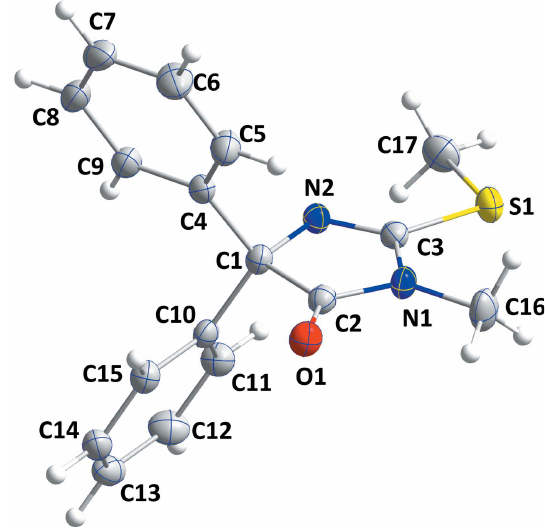
Figure 1 The title molecule with the atom-labeling scheme and 50% probability ellipsoids.